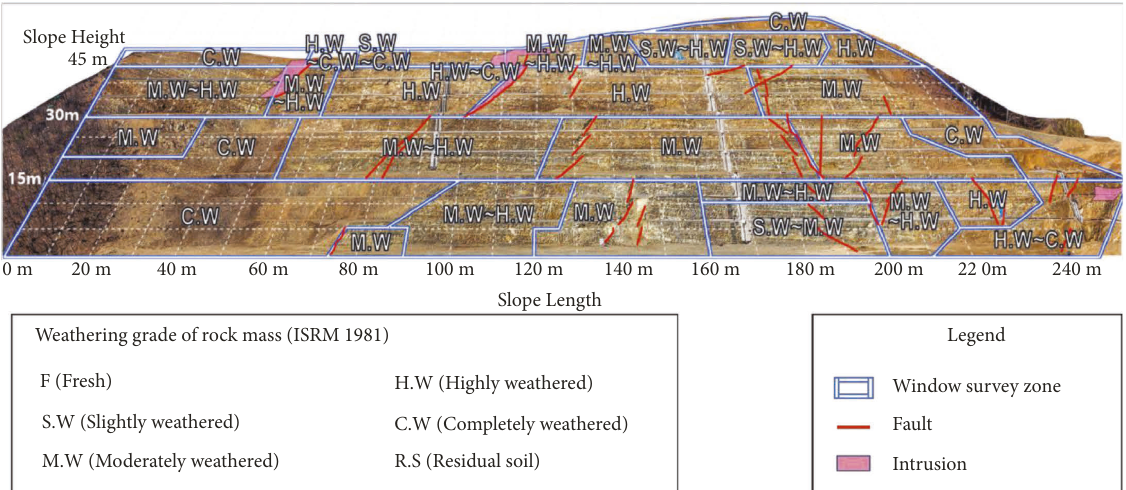
Figure 1: Cut slope for the time-history analysis, which is classified via its rock-weathering grade. The slope, which consists of soil (completely weathered, C.W.), highly weathered (H.W.) rocks, and moderately weathered (M.W.) rocks, is approximately 240m long and 60m high.